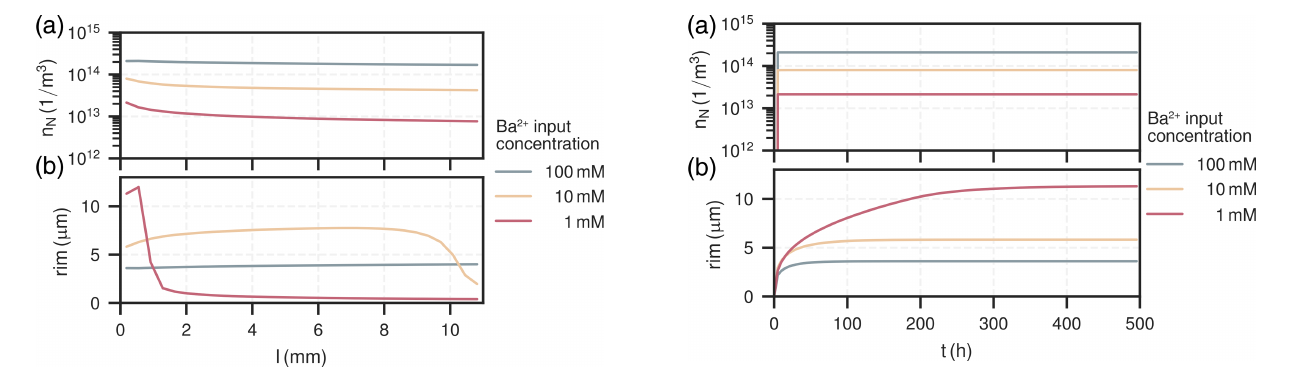
Figure 5. Temporal distribution of nuclei (a) and their correspond- ing rim thickness (b) in the first cell (0–0 . 37mm) over the course of the experiment for all